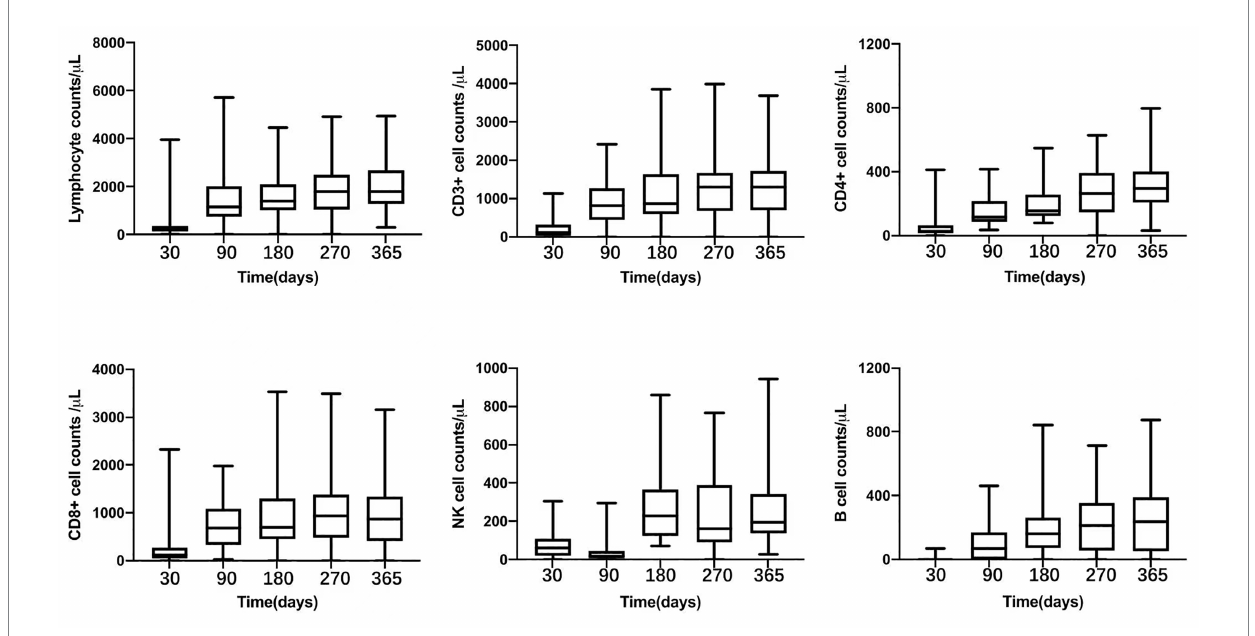
FIGURE 3 Peripheral lymphocyte counts after transplantation: total lymphocyte oucnt, CD3+, CD4+, CD8+, NK cell, and B lymphocyte.